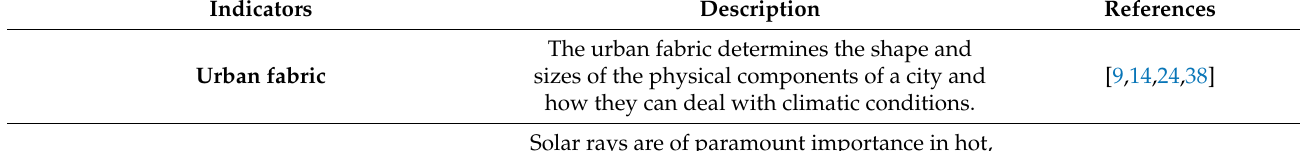
Table 2. The proposed indicators, their relevance to sustainability, and the references upon which they were based.